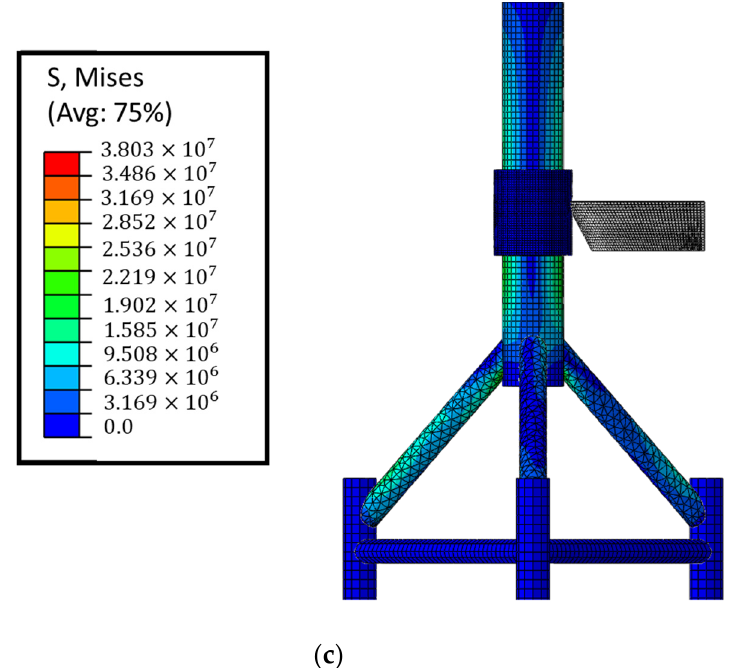
Figure 14. Mises Stress distribution of the OWT with the different materials. ( a ) AFS fender; ( b ) ACS fender; ( c ) PUFS fender.